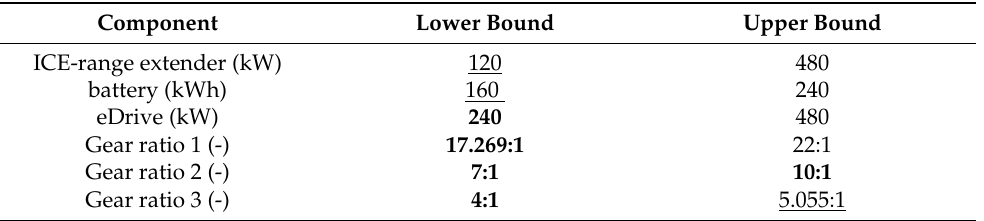
Table 4. Component sizing parameters, constraints and interdependencies (design variable limits). Underlined values represent fixed (hard) constraints and bold values show design